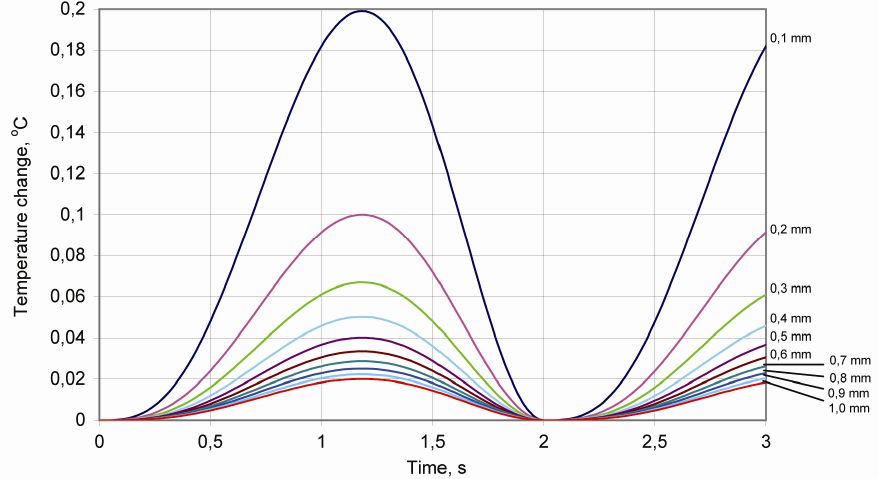
Fig. 8. Local temperature pulsations in the plant leaf depending on leaf plate thickness when plant –1 leaf oscillation frequency is 0.5 s and amplitude β A =